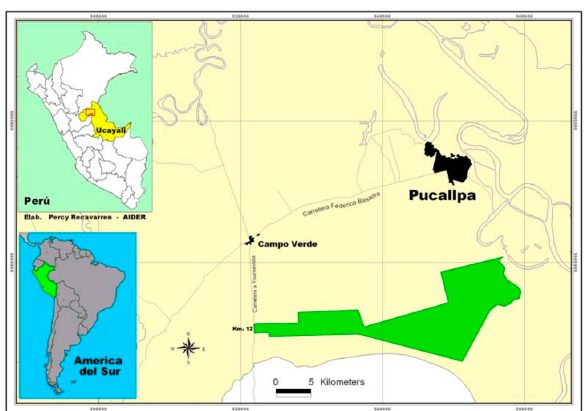
Figure 1. Location of the Campo Verde Project on the central eastern side of Peru. Forests 2018 , 8 , x FOR PEER REVIEW